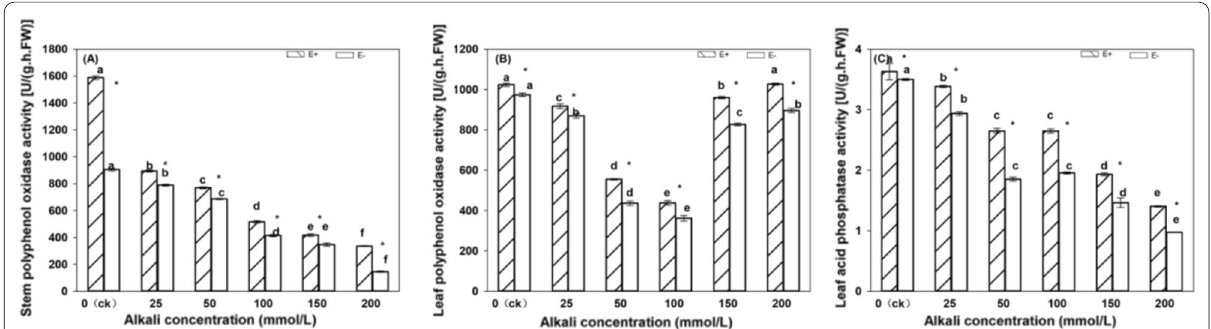
Fig. 5 Polyphenol oxidase activity and acid phosphatase activity in stems and leaves of E concentrations of alkali (picture A is polyphenol oxidase activity in stem, picture B is polyphenol oxidase activity in leaves, picture C is acid phosphatase activity in leaves)